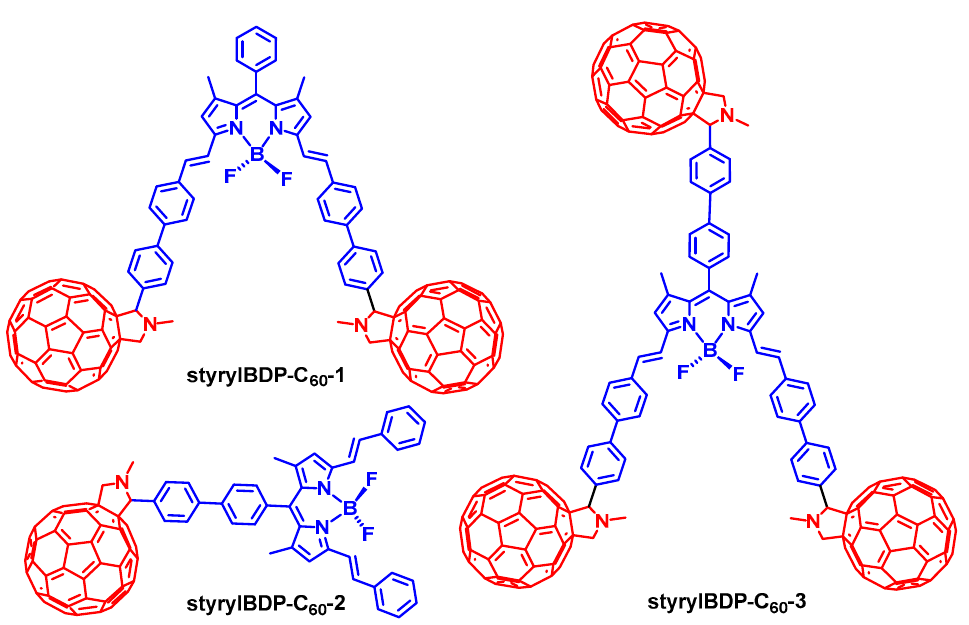
Figure 16. Molecular structures of the antenna-C 60 heavy atom-free triplet PSs based on red light- absorbing styrylBodipy antennae.